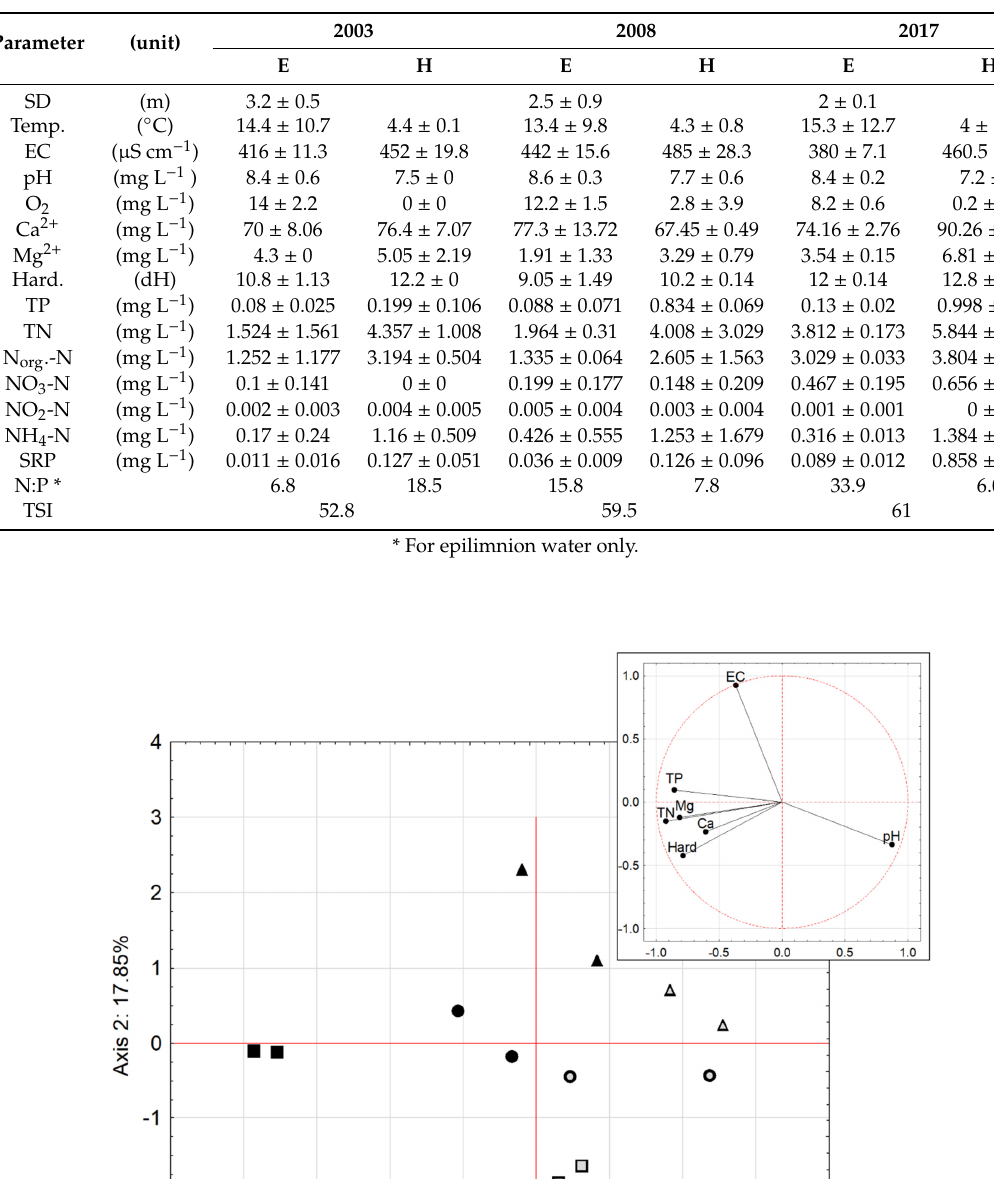
Table 2. Physicochemical characteristic of Lubi´nskie Lake epilimnion (E) and hypolimnion (H) water over three years of study: 2003 [43], 2008 (unpublished data) and 2017. The mean value ± standard deviation is given for each year.